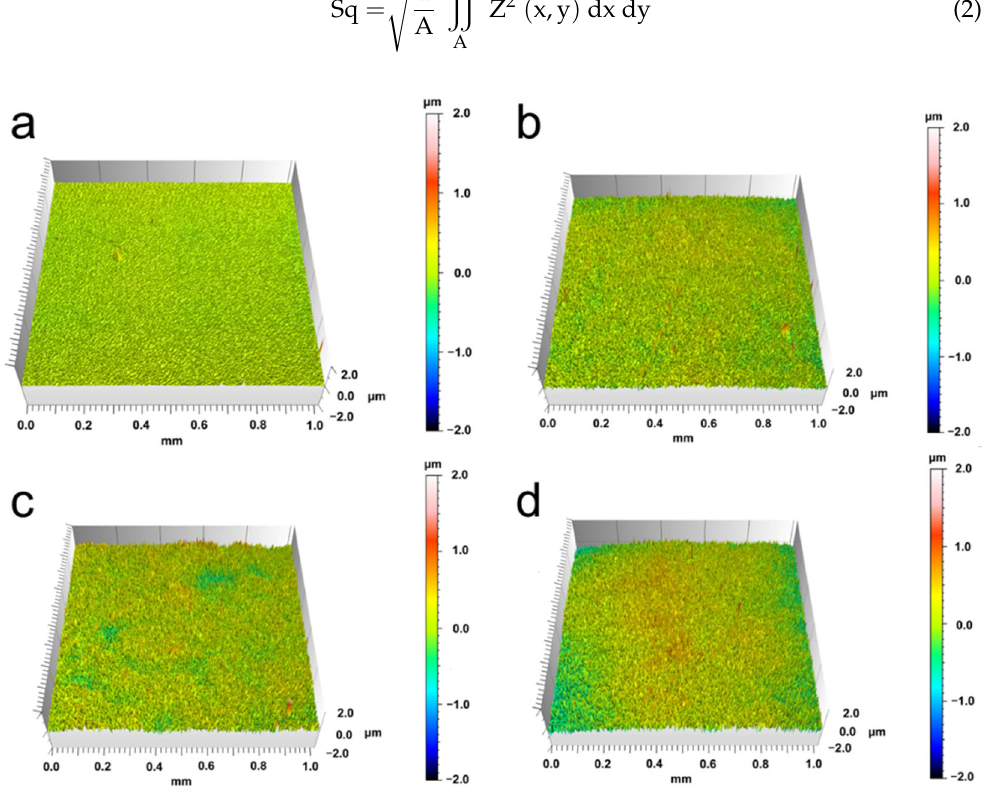
Figure 6. Three − dimensional confocal micrographs of ( a ) 316L substrate and Nb-Zr alloying layer and at pressures of ( b ) 30 Pa, ( c ) 40 Pa, and ( d ) 50 Pa.